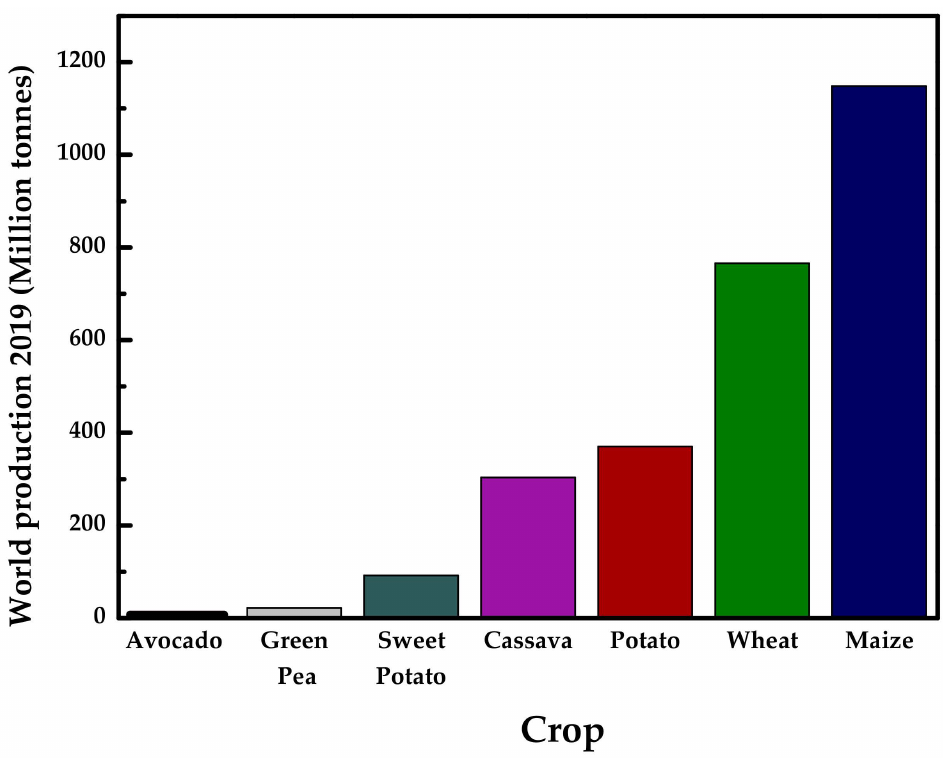
Figure 2. World production of main starch crops in 2019 (million tonnes). Prepared from data in